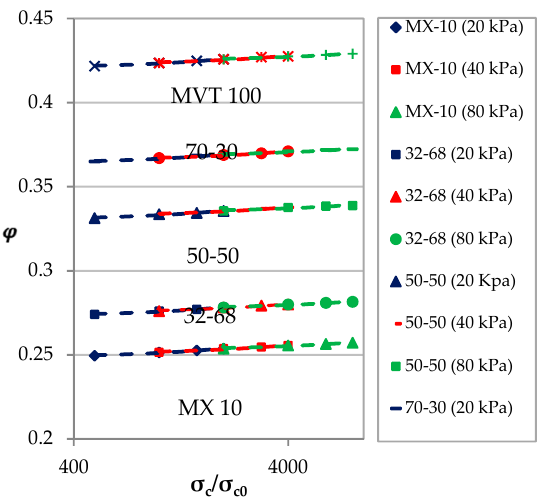
Figure 5. Particle volume fraction as a function of dimensionless applied consolidation stress.